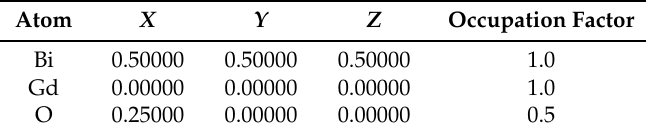
Table 1. Structural parameters of BiGdO 3 .